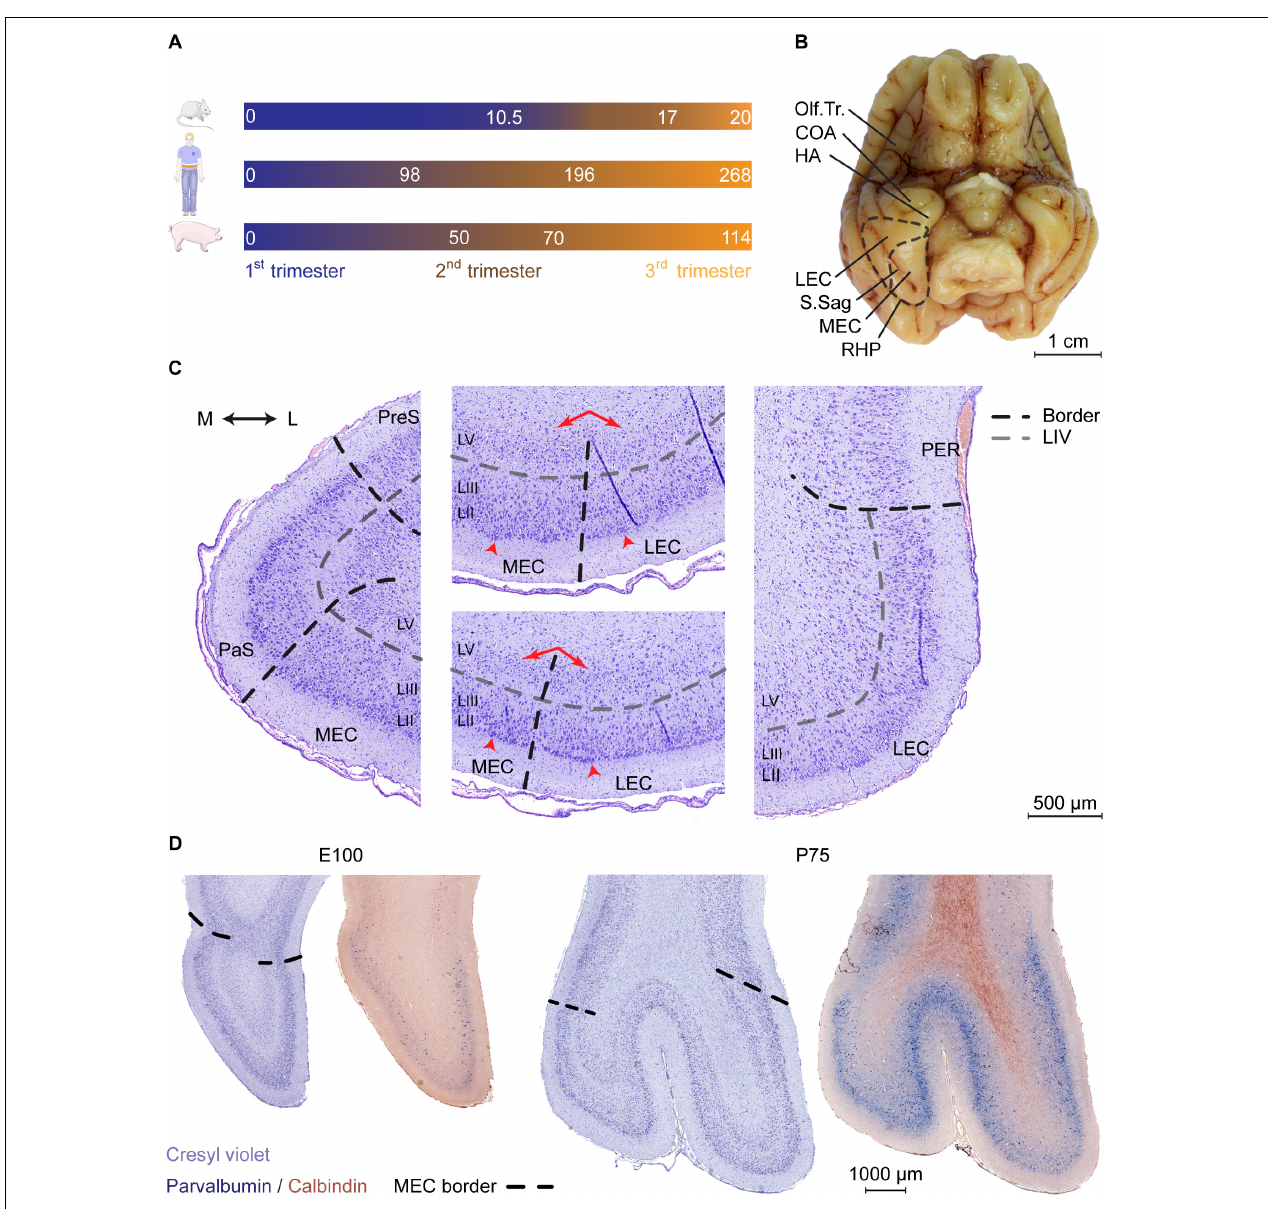
FIGURE 1 | Cytoarchitectonic features of the developing porcine entorhinal cortex. (A) Length and trimester divisions of the gestation in mouse, human, and pig. (B) Macroscopic view of the ventral surface of the porcine brain at Embryonic day (E)100 with annotation of the piriform lobe including the entorhinal area. Dashed black line indicates the outline of EC and the border between lateral and medial entorhinal cortex. Olfactory tract (Olf.Tr.); caudate nucleus of amygdala (COA); hippocampal area (HA); lateral entorhinal cortex (LEC); medial entorhinal cortex (MEC); sagittal sulcus (S.Sag); posterior rhinal sulcus (RHP; note that the sulcus coincides with the visible lateral border of the EC). Scale bar 1 cm. (C) Delineations and cytoarchitectonic features of cresyl violet stained coronal sections of the EC (shown at E100 as representative). Light gray punctuated line marks the acellular layer (L)IV l amina dissecans , black punctuated line borders between MEC and LEC or EC and adjacent areas. Red arrows (middle panels) shows the difference in the cellular organization in deep layers, arrowheads highlight large superficial cells of the EC. Medial (M); lateral (L); pre-subiculum (PreS); para-subiculum (PaS), perirhinal cortex (PER). Scale bar 500 µ m (D) Cresyl violet staining and parvalbumin (PVALB) expression highlights the caudal boundaries of the EC at E100 and P75 (coronal plane). PVALB expression coincides with defined cytoarchitectonic borders of the EC. Scale bar 1000 µ m.